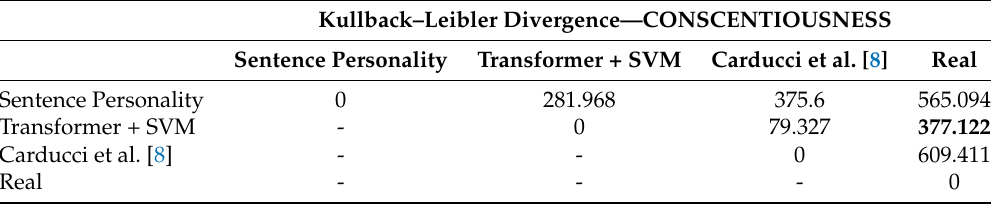
Table 5. Kullback–Leibler divergence computed among probability distributions on Conscientiousness.